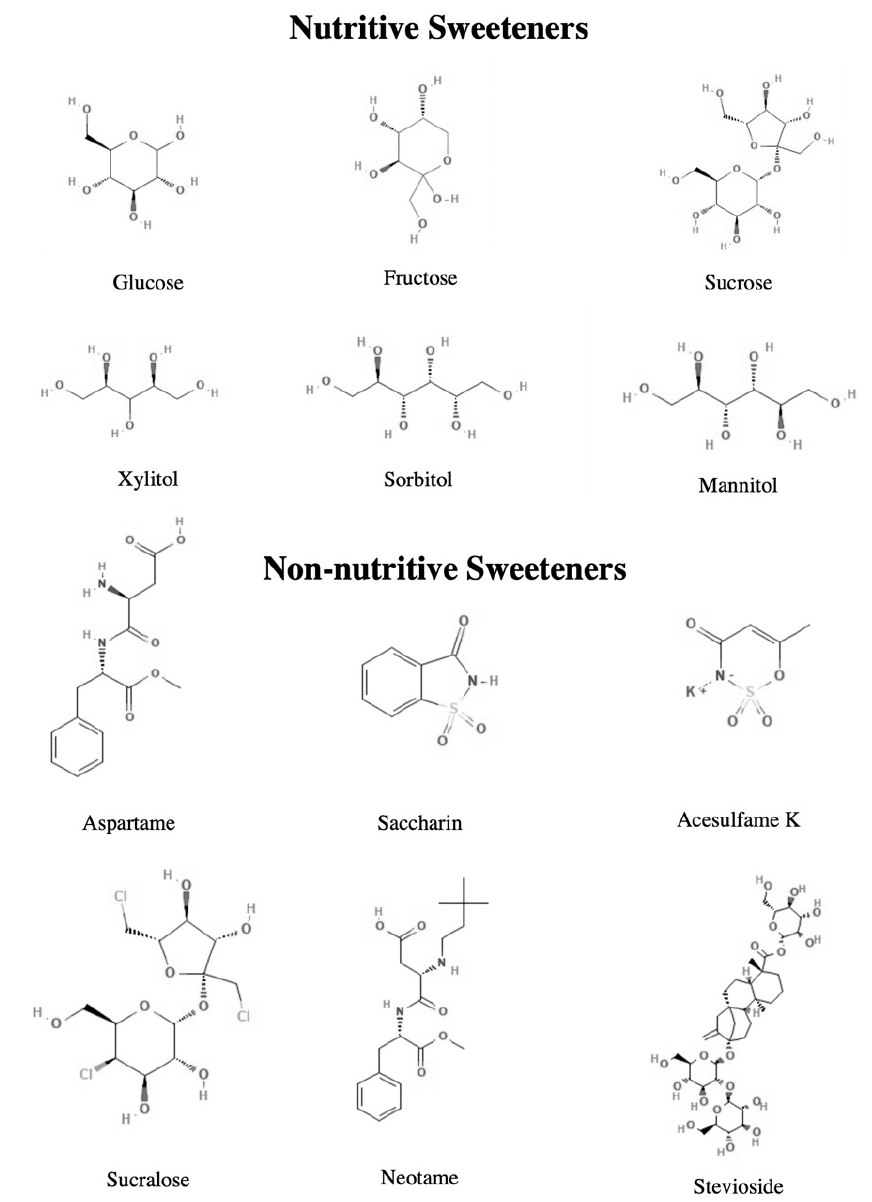
Figure 1. Nutritive and non-nutritive sweeteners chemical structures (Taken from: https://pubchem.ncbi.nlm.nih.gov/, accessed on 23 August 2022).